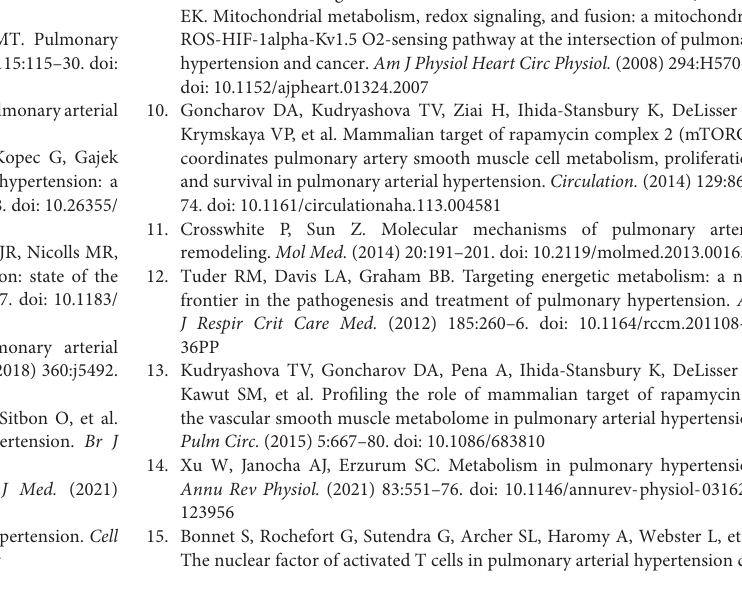
Supplementary Figure 1 | (A,B) Early passage distal primary human PAVSMC from non-diseased (CTRL) and PAH subjects were serum-deprived for 48 h and subjected to immunoblot analysis to detect indicated proteins. (A) n = 5 (CTRL), n = 7 (PAH) (see Figure 1B for statistical analysis). (B) Data are means ± SE, fold to control, n = 5 subjects/group. Supplementary Figure 2 | Early passage PAVSMC from five non-diseased (CTRL) and seven PAH subjects were serum deprived for 48 h and subjected to immunoblot analysis to detect indicated proteins. Immunoblots (A) and statistical analysis (B) are shown. (B) Data are means ± SE, fold to control. Supplementary Figure 3 | Early passage human PAH PAVSMC were treated with Akt inhibitor VIII, JNK inhibitor HY-14761, or diluent (0) and subjected to immunoblot analysis to detect indicated proteins. Data are fold to diluent-treated group. * p < 0.05 by Kruskal–Wallis rank test with Dunn pairwise comparison post hoc test. Supplementary Figure 4 | Early passage human control (non-diseased) PAVSMC were treated with (A) PDGF-BB (60 ng/ml) or (B) IL-6 (20 ng/ml) and appropriate vehicles for 48 h followed by immunoblot analyses of indicated proteins. Representative immunoblots and statistical analyses are shown. Data are means ± SE, n = 3 subjects/group, * p < 0.05, by Mann–Whitney U test. Supplementary Figure 5 | Early passage human PAH PAVSMC were incubated in serum deprived media in presence of 2-Deoxy- D -glucose (2-DG) 10 mM (A) or 1 mM (B) and/or Akt inhibitor VIII (1 µ M) or vehicle ( − ). Forty-eight hours later cell proliferation (Ki-67) was analyzed. Data are means ± SE, percentage